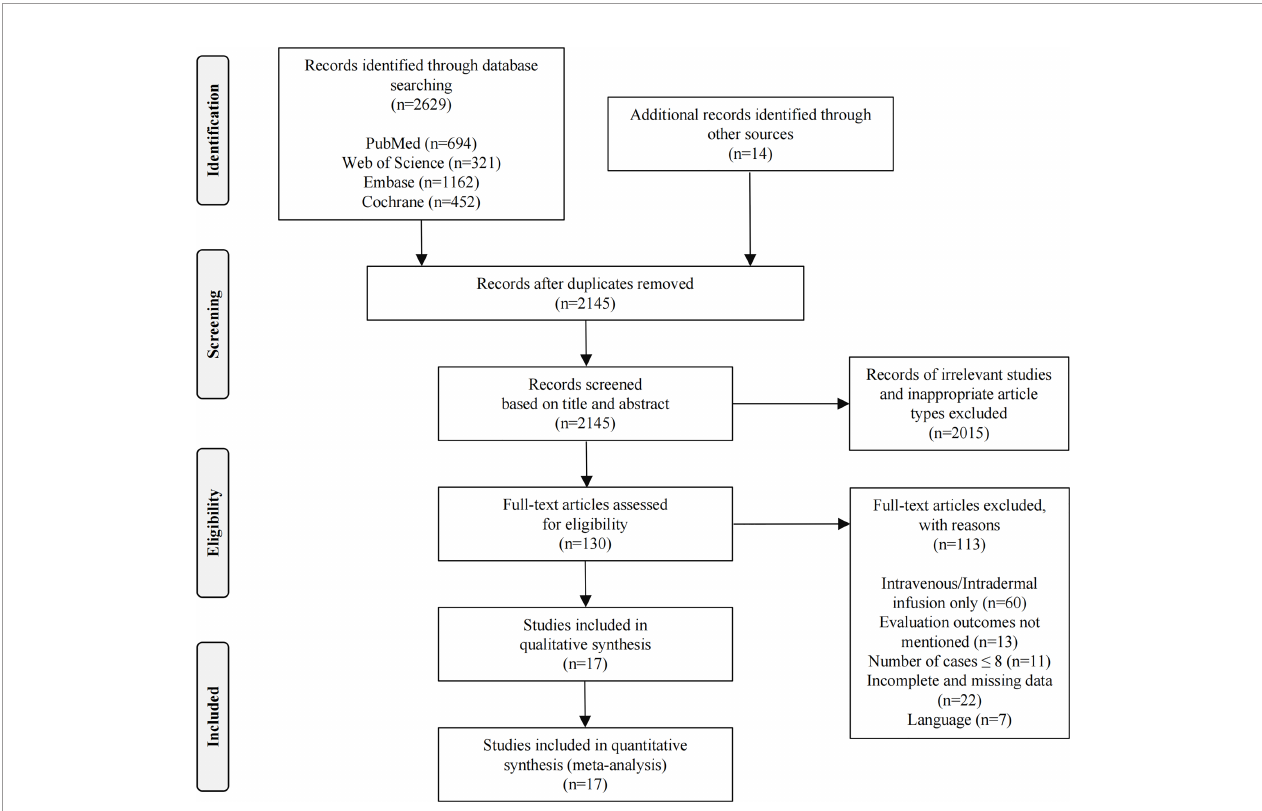
FIGURE 1 | Flow diagram of search results according to